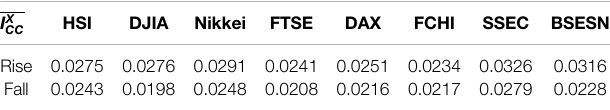
Figure 11 . Expected return data points are fi tted linearly and shown as black lines for rise motions and pink lines for fall motions, respectively, in Figures 10 and 11 . The slopes of the fi tting lines show the correlated relationships between expected returns and degree regardless of whether the trajectories are concave or convex. The larger the absolute slope, the more signi fi cantly a stock index exhibits a superexponential or a logarithmic motion.